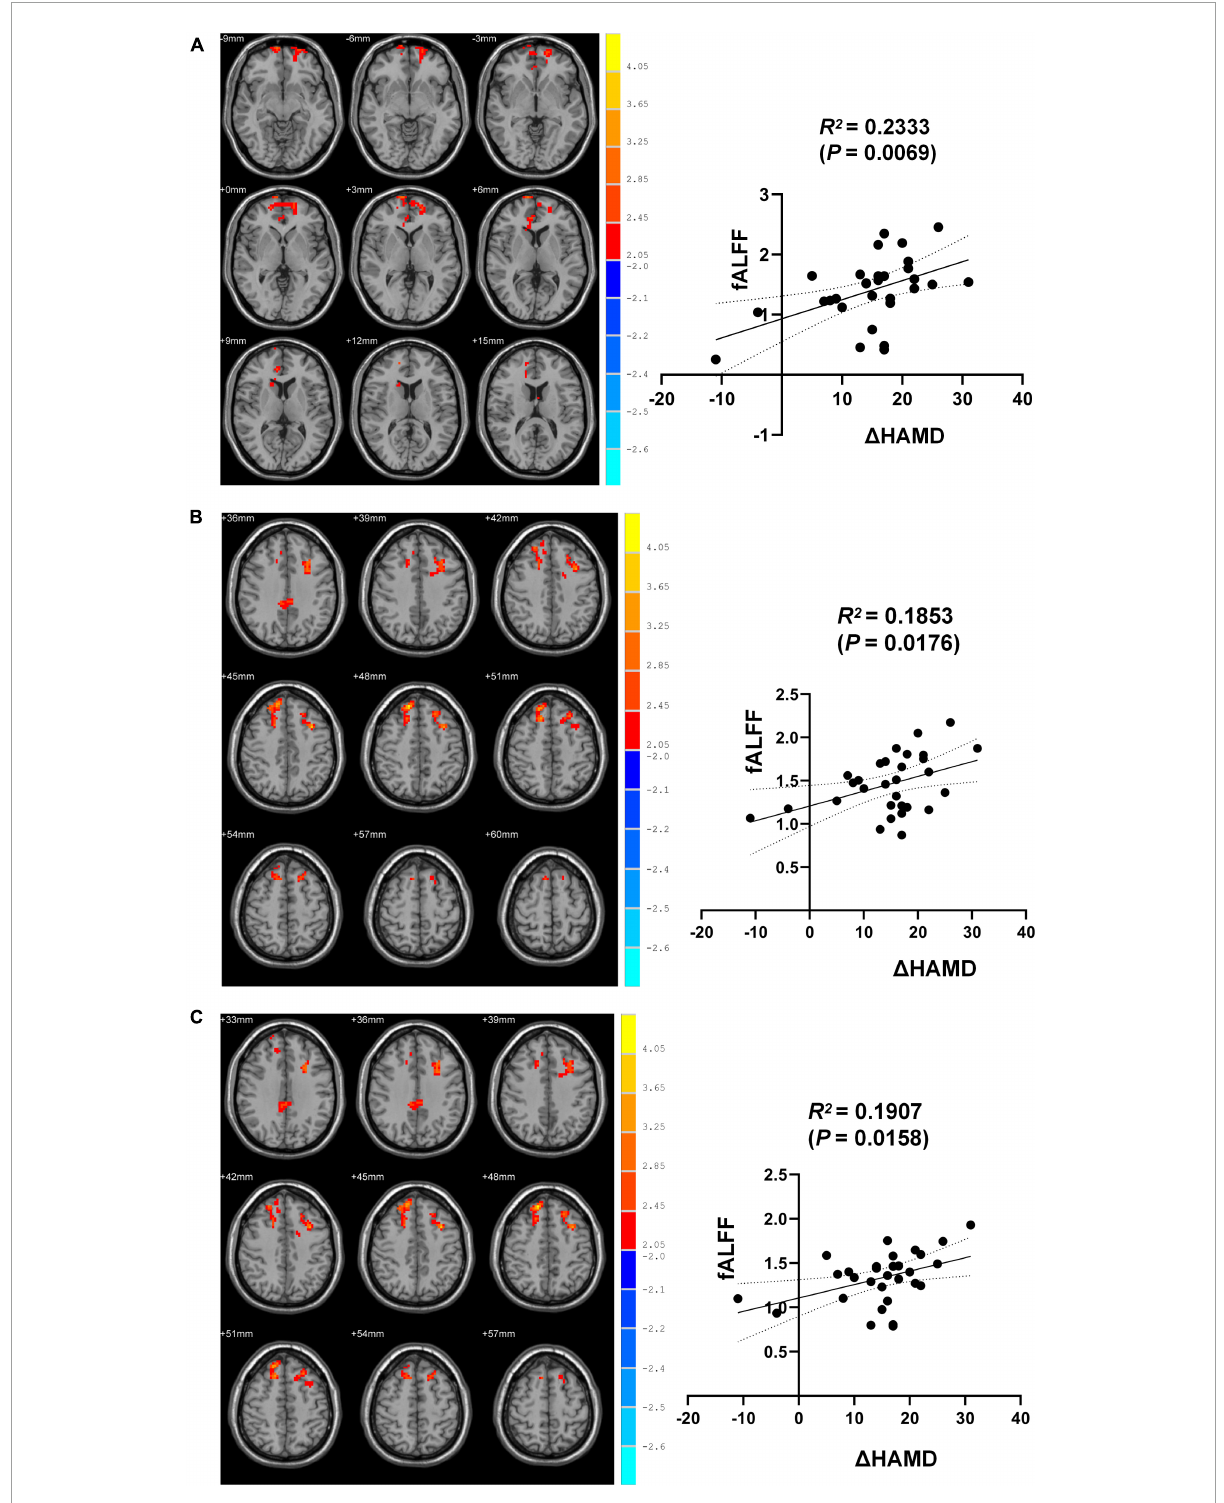
FIGURE2 Brain regions differences between pre-and post-ECT. (A) Correlation analysis of fALFF in brain regions (the right SFGmed) with difference and (cid:49) HAMD. (B) Correlation analysis of fALFF in brain regions (the right SFGdor) with difference and (cid:49) HAMD. (C) Correlation analysis of fALFF in brain regions (the left MFG) with difference and (cid:49)